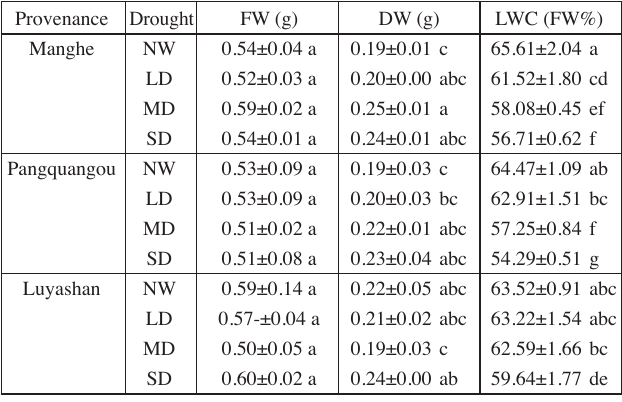
Tab. 3: The effect of drought on leaf fresh weight (FW), leaf dry weight (DW) and leaf water content (LWC, FW%) of three provenances for Dioscorea nipponica Makino.